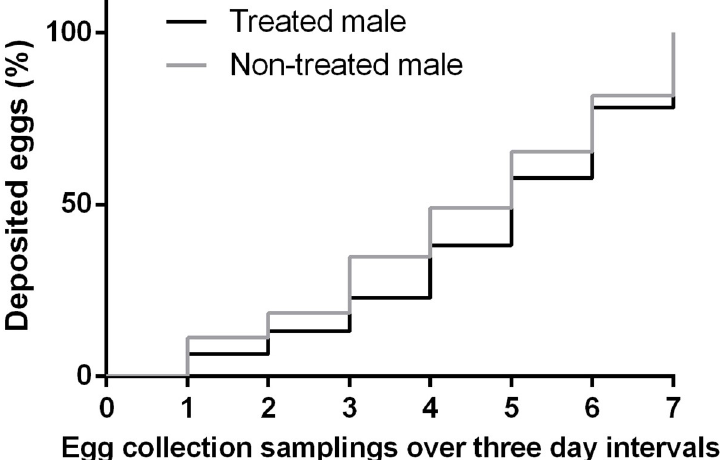
Fig 6. Temporal pattern of egg deposition by females mated to males treated or non-treated with methoprene. The cumulative percentage of eggs laid (y axis) across 7 egg collection samplings (x axis) is presented for the two types of females. Each sampling was carried out every three